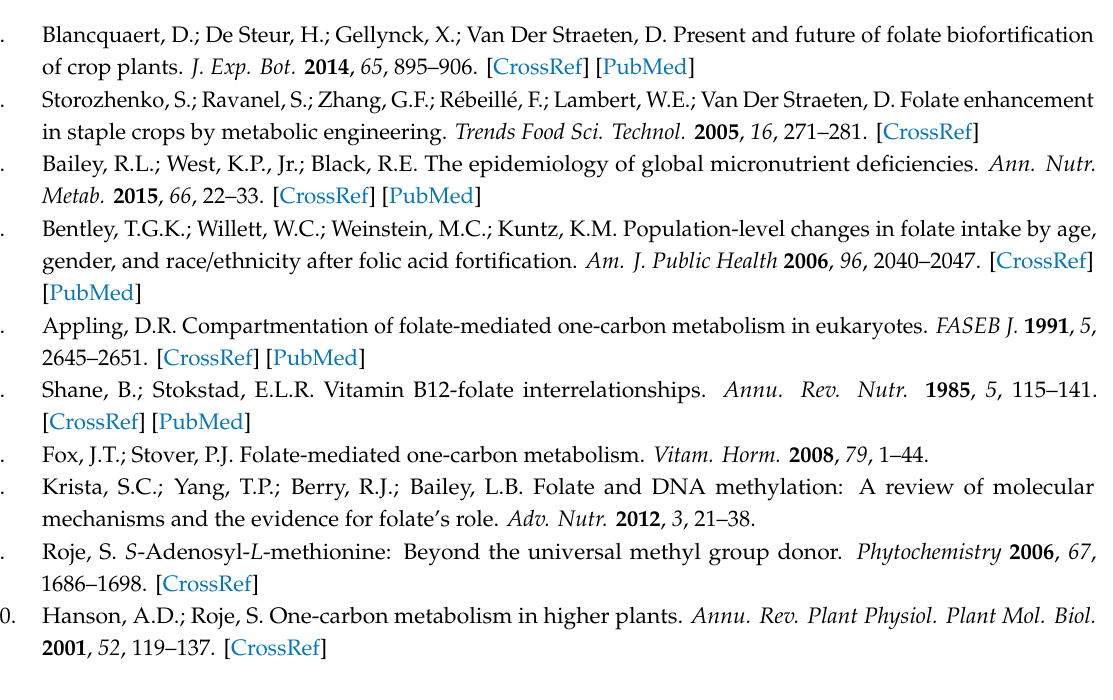
Figure S1. Partial alignments of GGH (A) and EF1- α (B) sequences and primers used in qPCR reactions. GGH1, GGH2 and GGH3 transcripts sequences from the DM genotype were aligned in order to design primers specific of GGH1. EF1- α sequences from four potato genotypes were aligned to design primers within highly conserved regions. Figure S2. Venn diagram showing numbers of di ff erentially expressed genes that are common or exclusive in comparisons fol 1.6 versus fol 1.5 and fol 1.3 versus fol 1.5. Figure S3. Functional enrichment analysis in comparisons between fol 1.6 and fol 1.5, and fol 1.3 and fol 1.5. Analyses were done using g:GOSt in g:Profiler. A g:SCS threshold of 0.05 was used. The top panel is a Manhattan plot of enriched terms in the comparison between fol 1.6 and fol 1.5. The middle panel is a Manhattan plot of enriched terms in the comparison between fol 1.3 and fol 1.5. The bottom table provides detailed information such as data source, id and name of the term with corresponding p -value. The light circles in Manhattan plots represent insignificant terms.Figure S4. Phylogenetic tree of UDP-glucose glucosyltransferases from potato and Arabidopsis. Homologs of the At1g05560-encoded protein were searched in the potato genome by using tBLASTn search in Spud DB (http: // potato.plantbiology.msu.edu / ). The seven top matches were used for phylogenetic analysis in MEGA7. Figure S5. Histogram of number of individuals within folate concentration brackets. A, BRR1 population; B, BRR3 population. Figure S6. Alignment of potato and Arabidopsis GGH proteins. Asterisks indicate conserved residues that are catalytically essential in human GGH or other conserved active site residues that may participate in substrate binding [29]. Alignment was done by CLUSTALW (https: // www.genome.jp / tools-bin / clustalw). Shading was done by BOXSHADE (https: // embnet.vital-it.ch / software / BOX_form.html). AtGGH1, At1g78660; AtGGH2, At1g78680; AtGGH3, At1g78670; StGGH1, PGSC0003DMG400007066; StGGH2, PGSC0003DMG400021256; StGGH3, PGSC0003DMG400035974. Table S1. Folate metabolism-related genes in Arabidopsis, tomato,